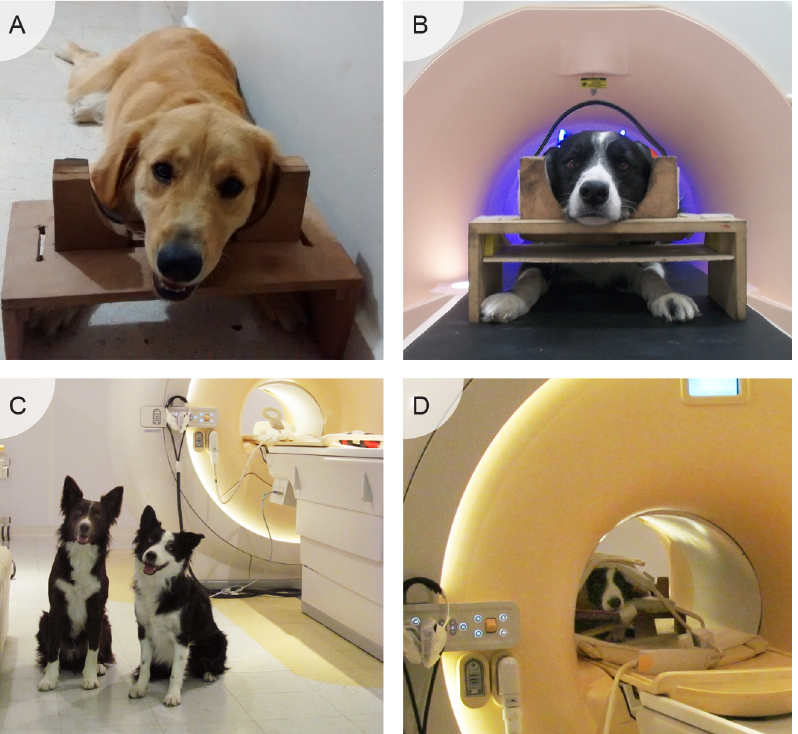
Fig 1. Training procedure for awake dog fMRI. During a period of approximately four months, dogs learned to stay still and attend to a visual stimulation paradigm within the MRI scanner. First, dogs learned to rest their chin and avoid movement ( A ), followed by habituation to the scanning environment, including scanner sounds and the use of protective headphones, in a mock MRI scanner ( B ). Next, dogs were further trained within the real MRI scanner ( C ) and habituated to the imaging coils ( D ). Upon completion of training, all dogs were able to lie still and awake for periods of up to 15